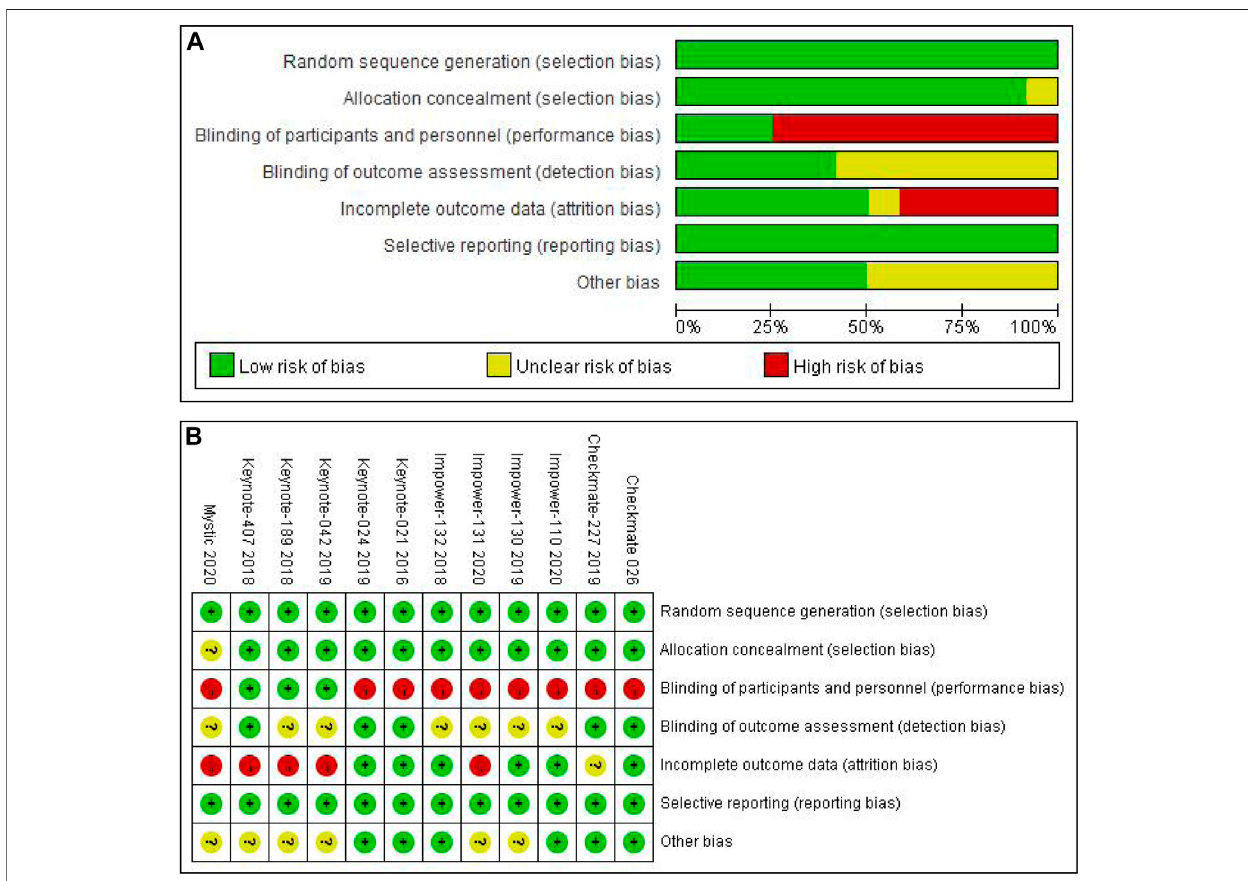
FIGURE 1 | The Cochrane risk bias assessment tool was used to evaluate bias from seven key sources: 1. Random sequence generation; 2. Allocation concealment; 3. Blindness of subjects and researchers; 4. Blindness of outcome evaluation; 5. Incomplete data; 6. Selective reporting of results; 7. Other biases. Green represents low risk, yellow represents unclear risk, and red represents high risk. (A) Risk of bias graph; (B) Risk of bias summary.